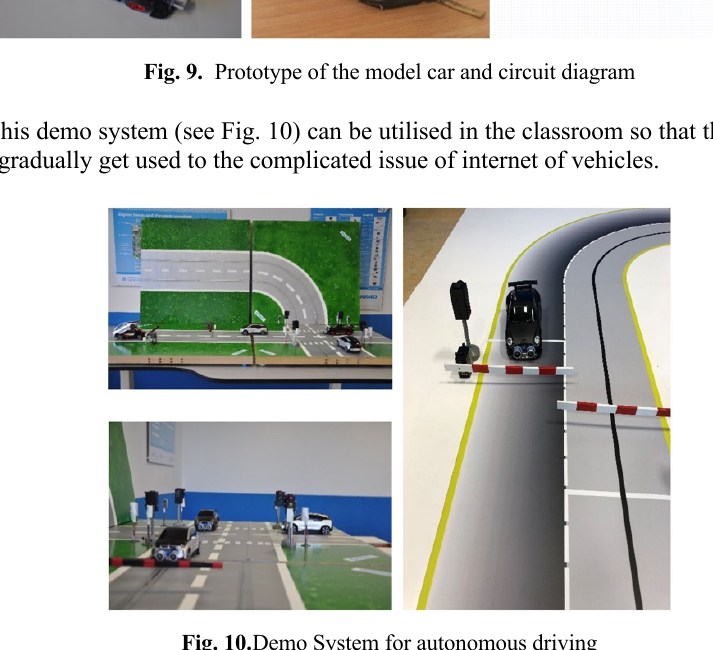
Fig. 10. Demo System for autonomous